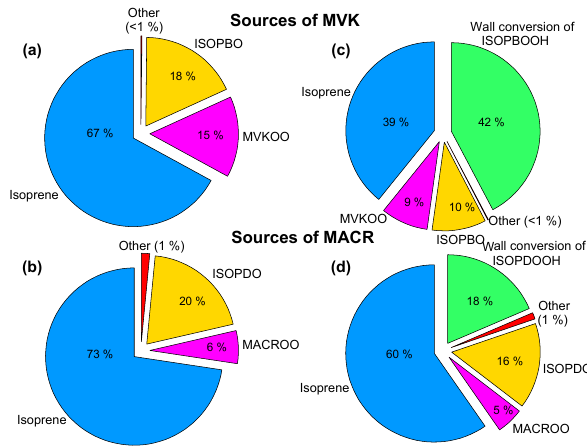
Figure 4. Sources of MVK and MACR according to the relative im- portance of their precursors without (a, b) and with (c, d) additional wall conversion of ISOPOOH. Inclusion of the wall conversion of ISOPOOH to the model simulations changes the importance of the respective formation pathways. See Table S1 in the Supplement for explanation of source